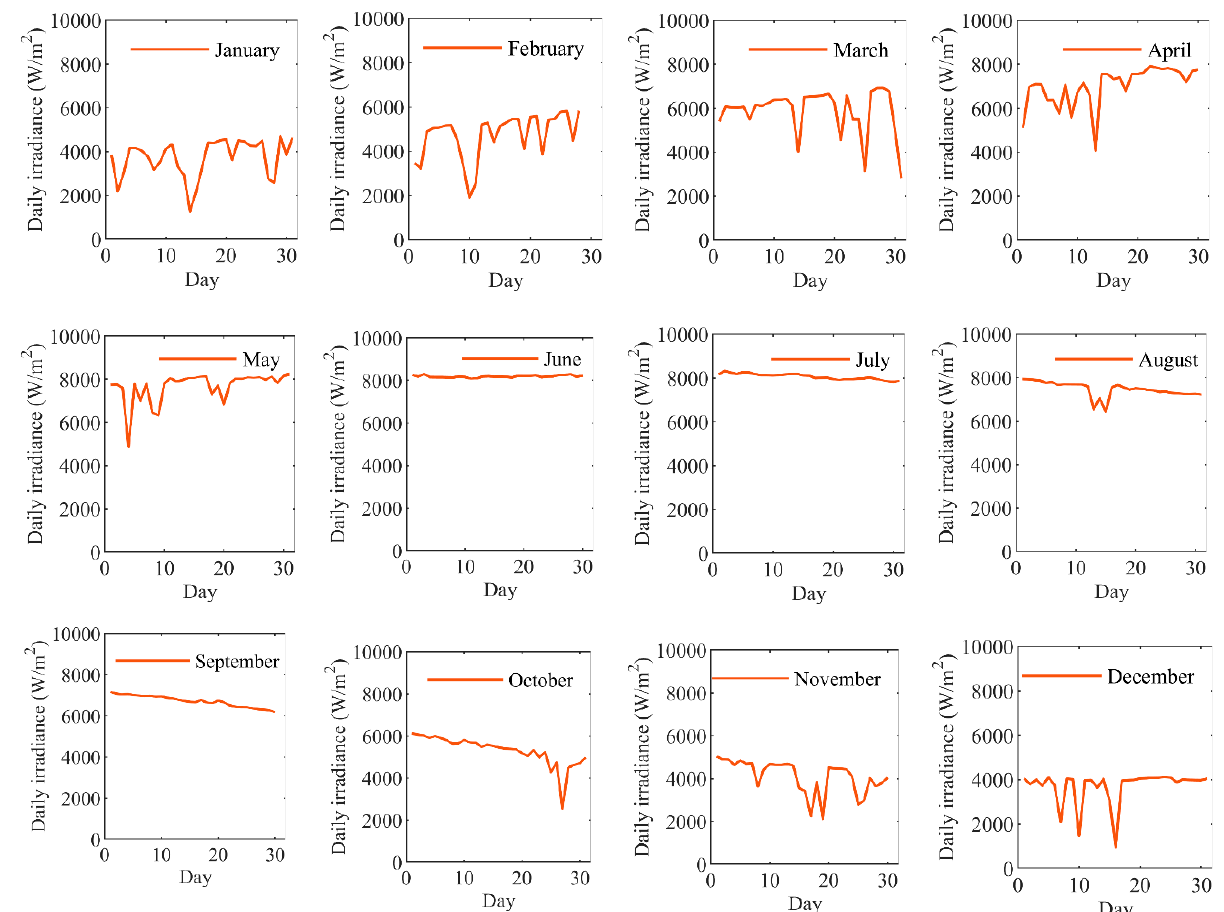
Figure 6. Daily variations of solar irradiance for all months in